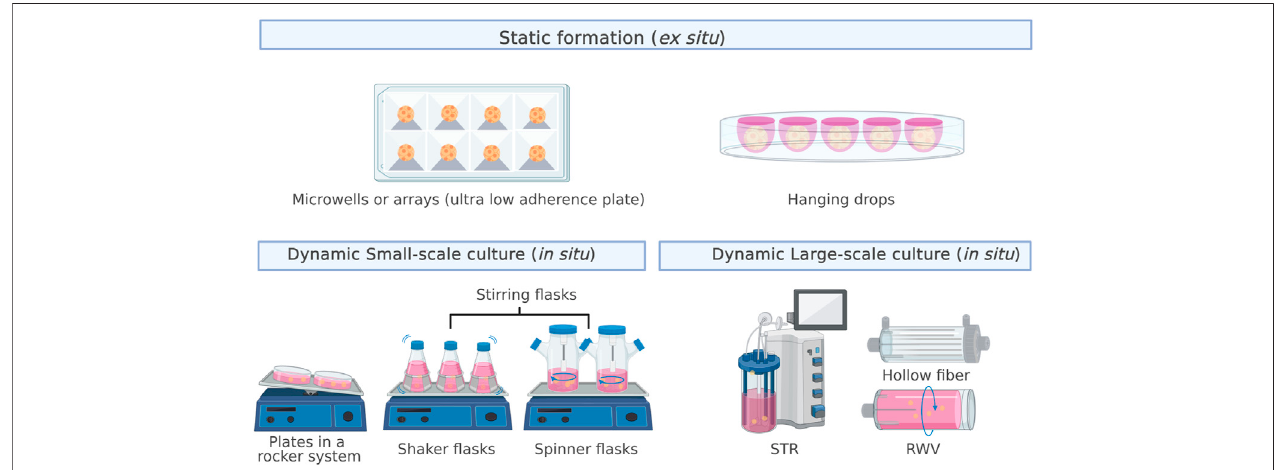
FIGURE1 | Strategies for static ( ex situ culture) and dynamic (in situ culture) spheroid formation. The most used approaches for static formation, also called MSCs self-assembly, are microwells and the hanging drop method. In contrast, dynamic formation, also called collision-based assembly, can occur in small- or large-scale